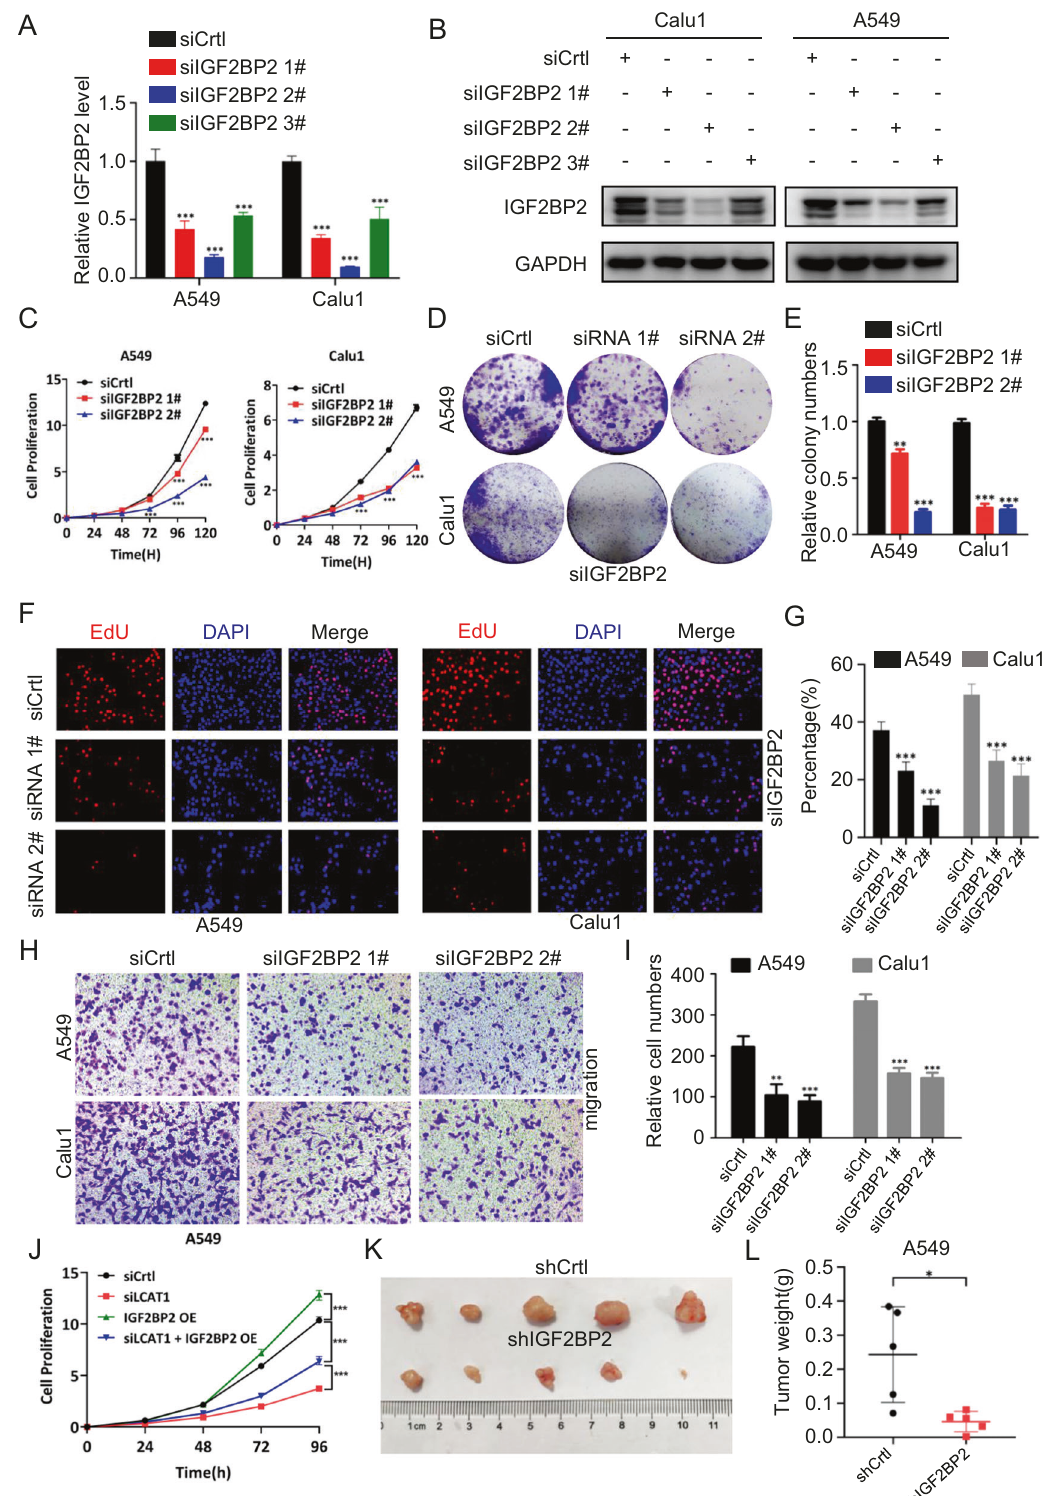
Fig. 3 IGF2BP2 promotes lung cancer cell proliferation and progression. A , B qPCR and western blot analyses con fi rmed that IGF2BP2 was successfully knocked down by siRNA in A549 and Calu1 cells. C – E CCK-8 and colony formation assays in the A549 and Calu1 cells with